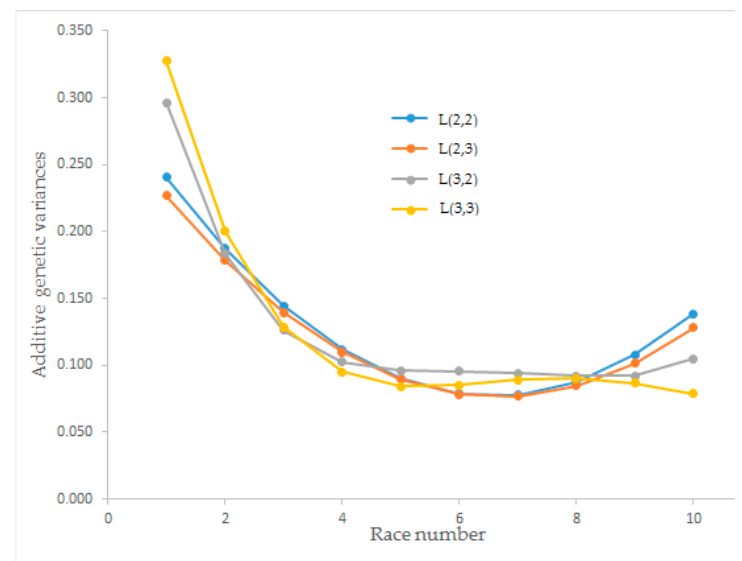
Figure 1. Estimation of the additive genetic variance for race speed from different orders of Legendre polynomial models.